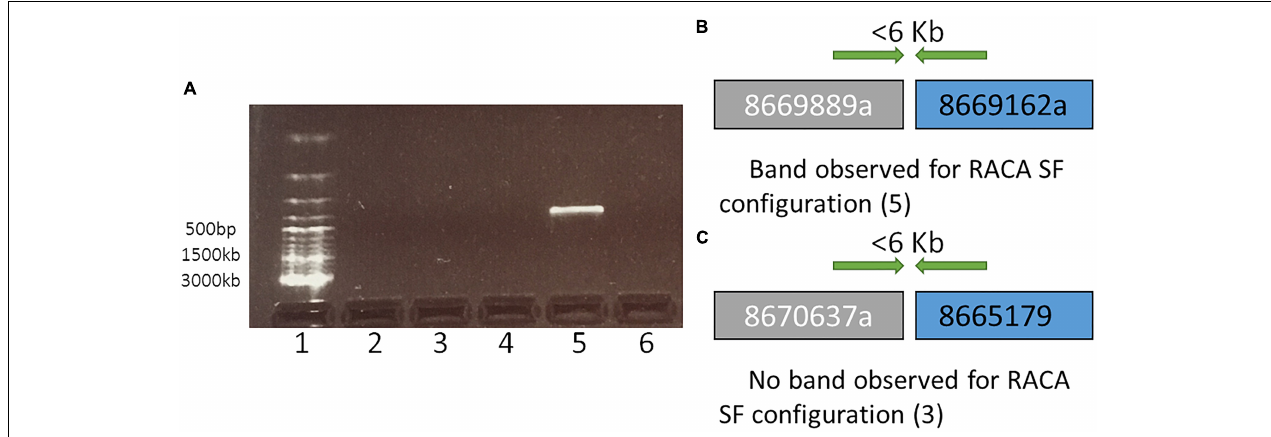
FIGURE 2 | A representation and interpretation of the results of PCR run II. (A) An electrophoresis gel, where in well 1 is a DNA ladder; 2 is the control (no DNA); 3, 4, and 6 show no amplification for tested SF adjacencies 8670637a and 8665179, 8667696a and 8667368, 8669739a and 8669686, respectively. Order of these SF was suggested by RACA; 5 exhibits amplification for adjacent SFs 8669889a and 8669162b in the order suggested by RACA. (B) A schematic representation and interpretation of the results form well 5 (SFs 8669889a and 8669162b were confirmed to be adjacent suggesting that the original scaffolds 8669889 and 8669162 these two SFs originate from were chimeric); (C) A schematic representation and interpretation of the results from well 3. The order of SFs 8670637a and 8665179, adjacent in RACA’s output was not confirmed due to no PCR amplification, suggesting that no conclusion about the chimeric nature of scaffolds 8670637 and 8665179 could be